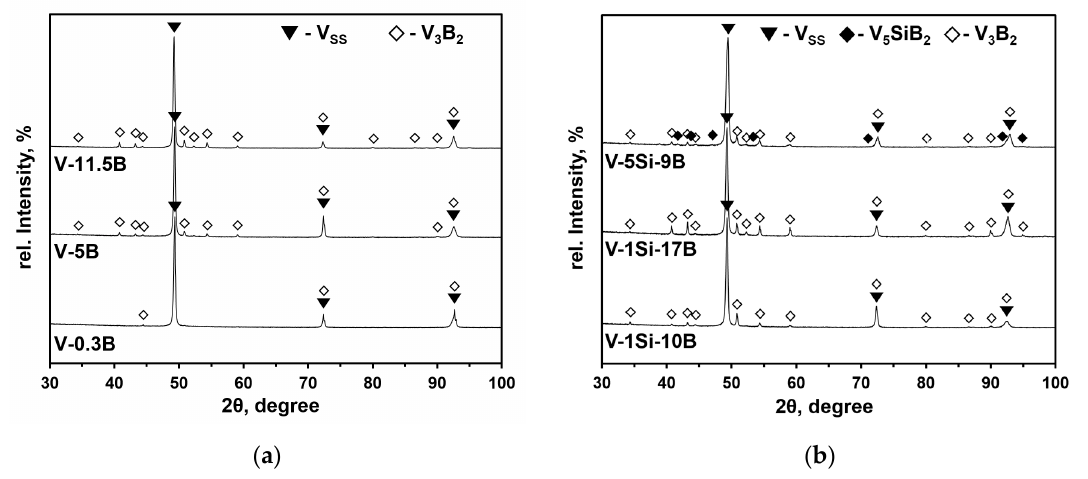
Figure 2. X ‐ ray diffraction (XRD) pattern of ( a ) V ‐ B alloys; ( b ) V ‐ Si ‐ B alloys. Figure 2. X-ray di ff raction (XRD) pattern of ( a ) V-B alloys; ( b ) V-Si-B